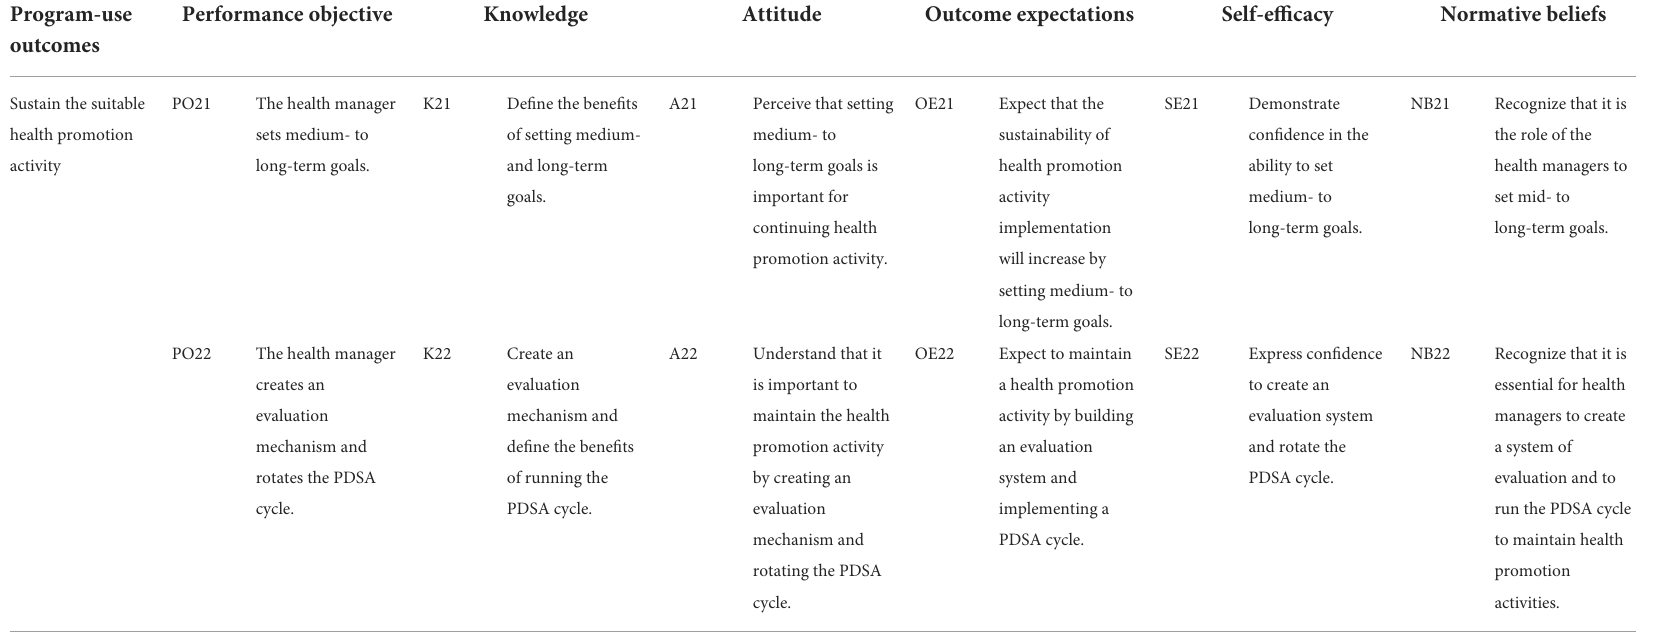
TABLE 3 Implementation Mapping process Task 2: